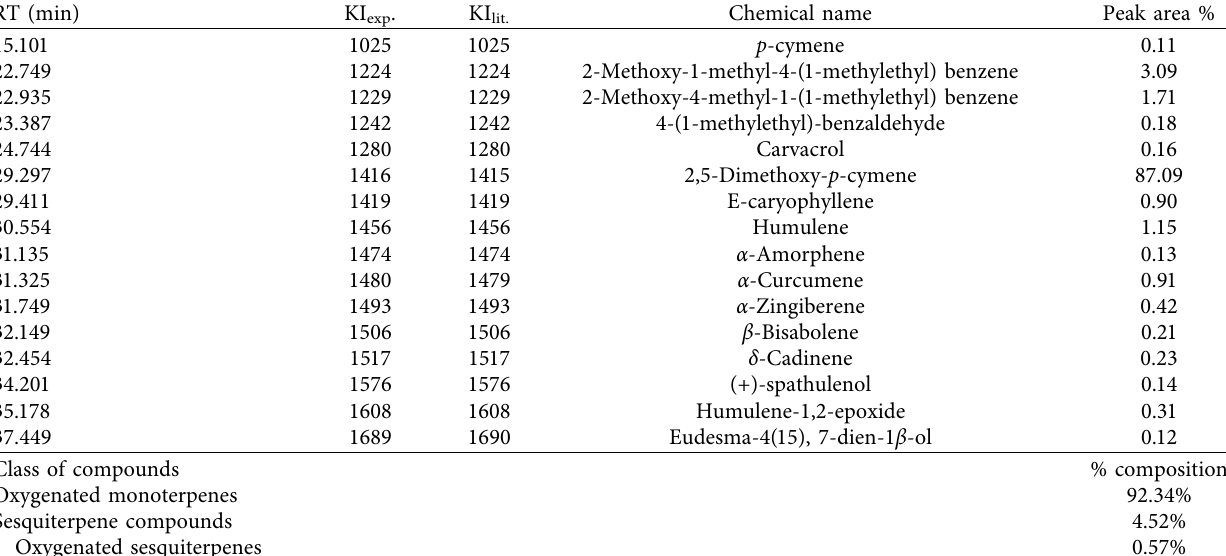
Table 1: Chemical constituents of CSEO isolated from aerial parts of C.